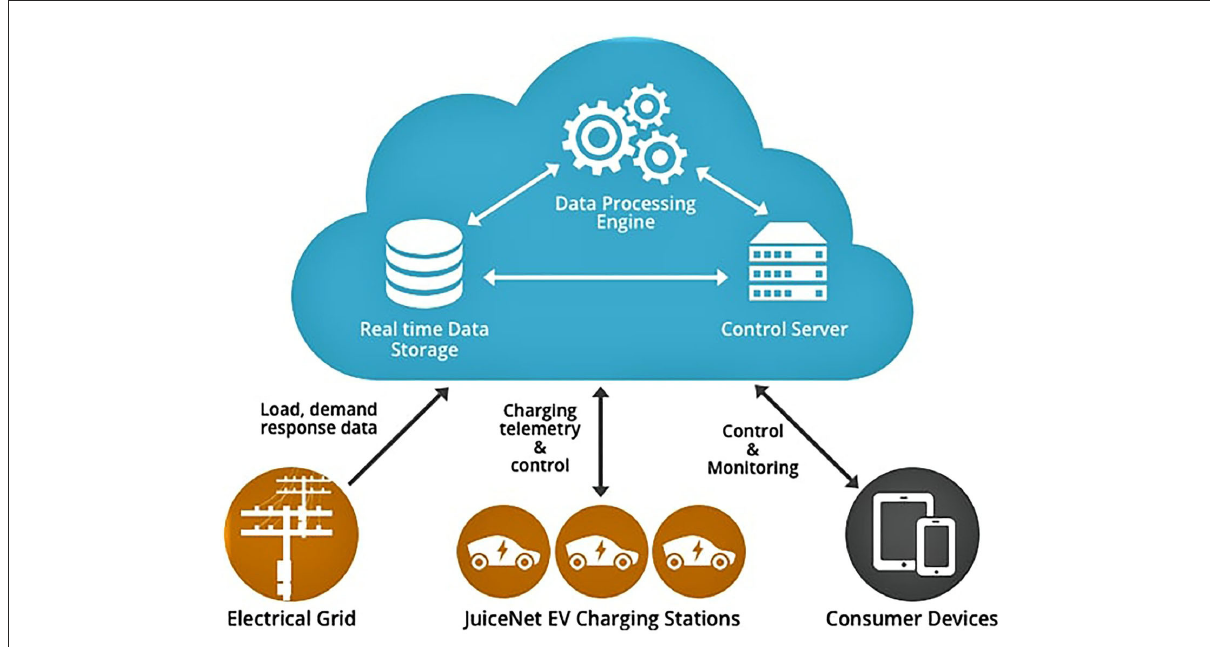
FIGURE2 An integration architecture of energy trading between local energy grids and EV charging stations (Greencar Congress,